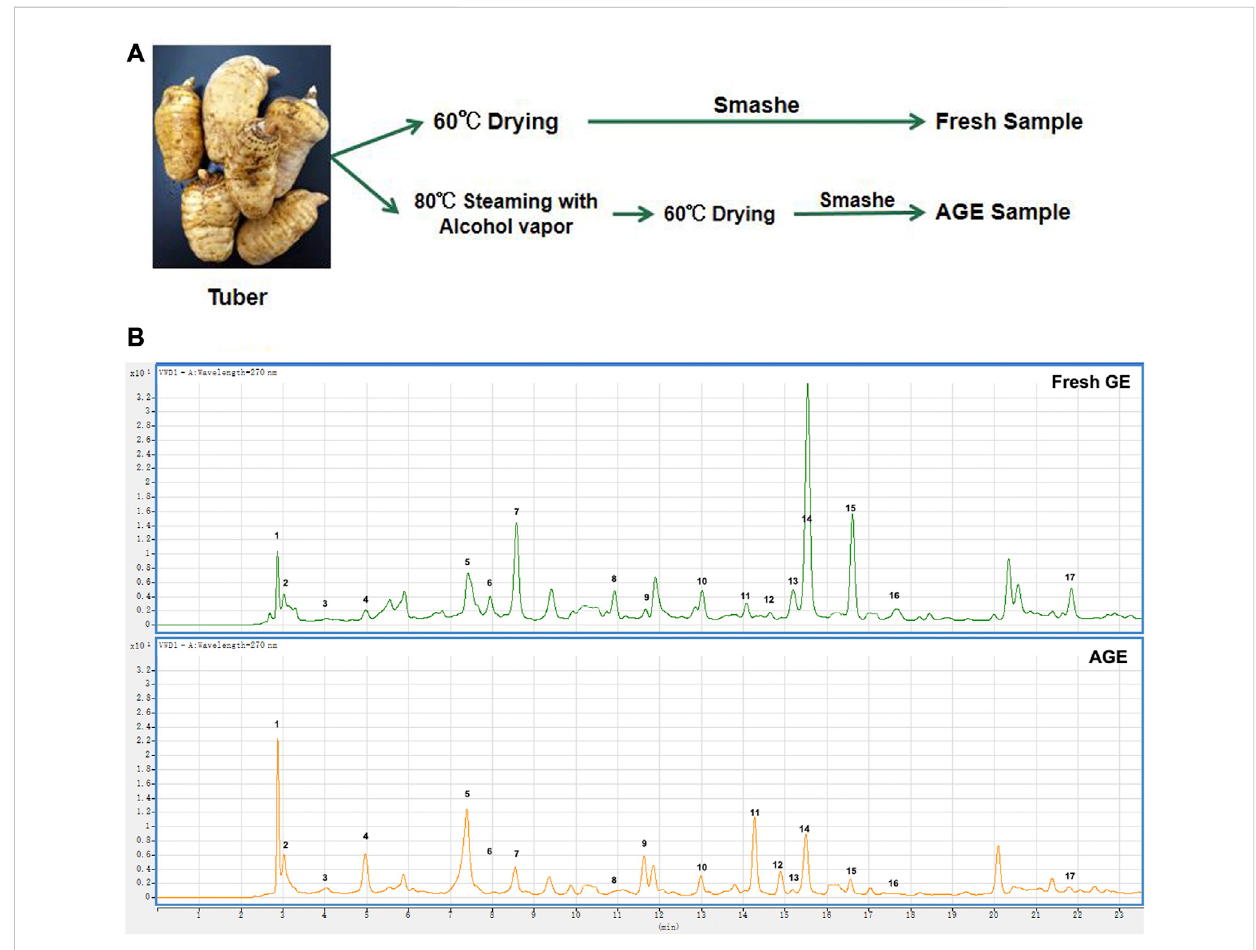
EffectofalcoholproceedonchemicalingredientsinGEsamples. (A) ThepreparationoffreshGEandAGEsamples. (B) TheHPLCchromatogramsof fresh GE and